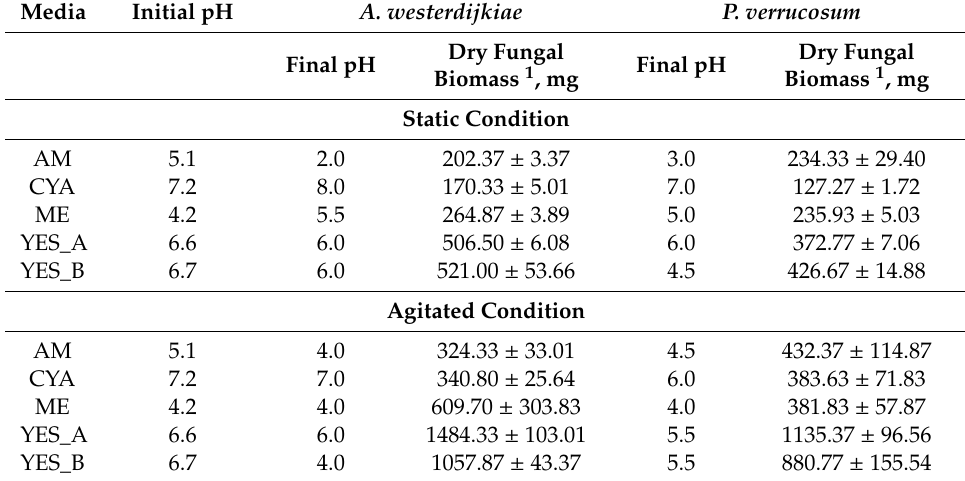
Table 1. Fungal growth of Aspergillus westerdijkiae and Penicillium verrucosum cultivated in five di ff erent media under static and agitated